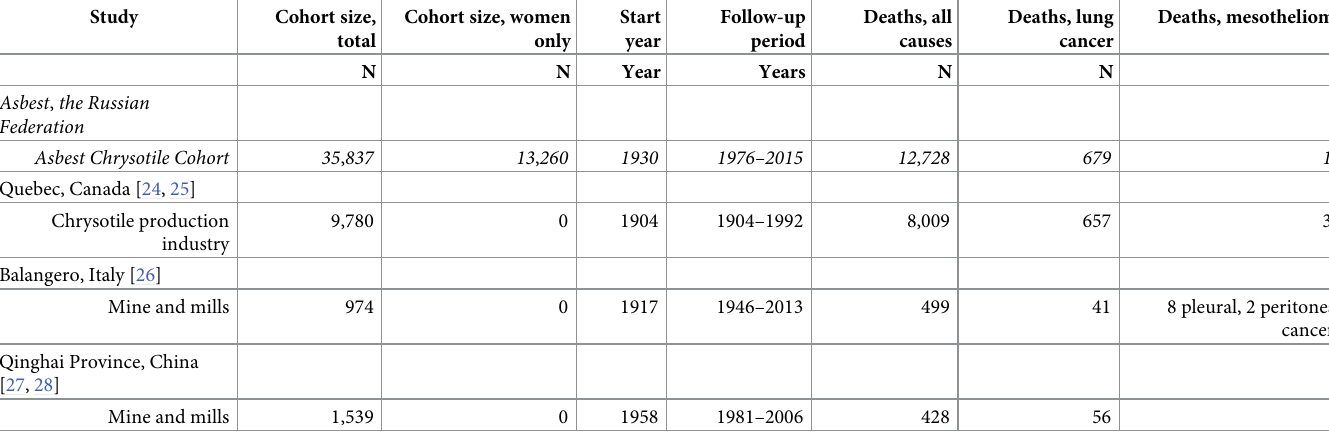
Table 4. Characteristics of cohorts of chrysotile workers in mines or processing facilities in comparison to the present Asbest Chrysotile